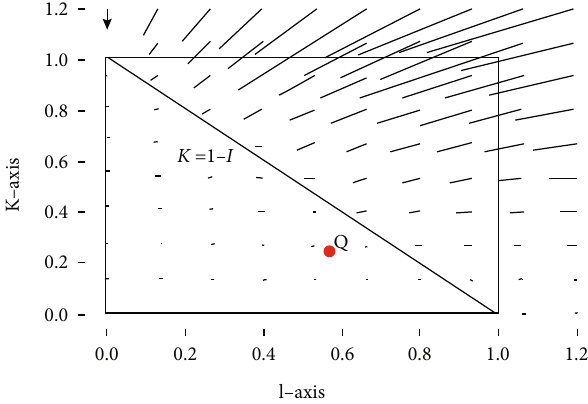
Figure 1: Vector fi eld (10): lengths of arrows indicate the rate at which fl ow is proceeding toward K = 1 − I